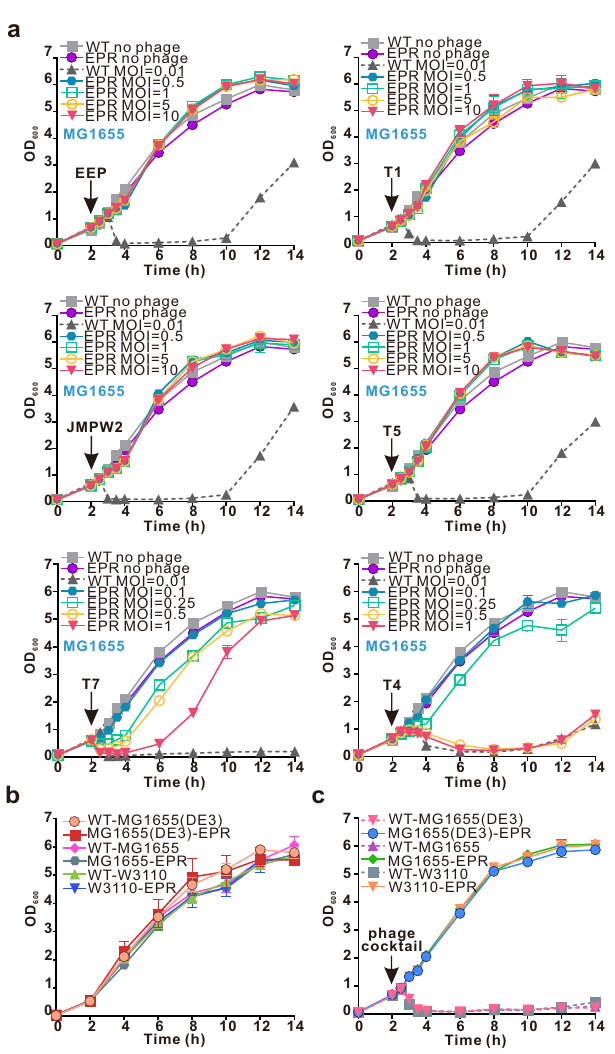
Fig. 3 Growth curves of the MG1655-EPR strain treated with coliphages at a range of MOIs. a MG1655-EPR strains were treated with the coliphages EEP, T1, T5, JMPW2, T7, and T4 at the indicated MOIs. WT- MG1655 and MG1655-EPR strains not treated with phages and WT- MG1655 treated with phages at MOI = 0.01 were set as control groups. Growth curves of W3110-EPR and MG1655(DE3)-EPR strains treated with coliphages at the indicated MOIs are shown in Supplementary Fig. 6. Experiments were repeated three times, and each point represents the mean ± SD. b , c Growth curves of wild-type and EPR E. coli strains not treated ( b ) or treated ( c ) with phage cocktail. The phage cocktail was composed of T1 (MOI = 10), JMPW2 (MOI = 10), T4 (MOI = 0.1), T5 (MOI = 10), T7 (MOI = 0.1), EEP (MOI = 10), and lambda (MOI = 0.5) and was added when the OD 600 reached 0.6. Experiments were repeated three times, and each point represents the mean ± SD. Source data are provided as a Source Data fi